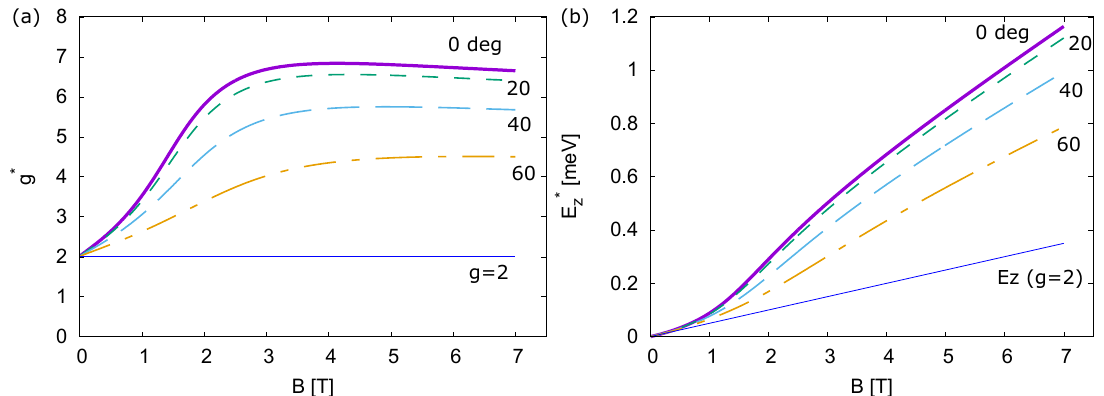
( b ), respectively, at T = 1.7 K for θ = 0 Z